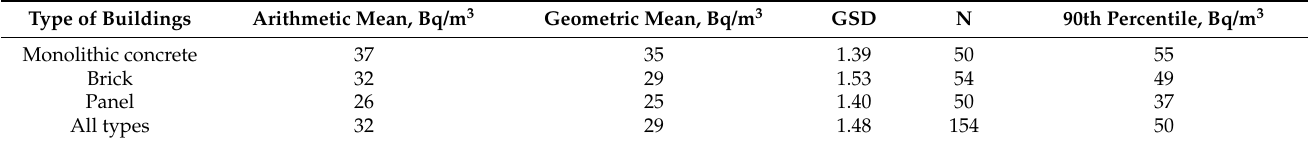
Table 4. Results of radon concentration measurements in Nizhny Novgorod.